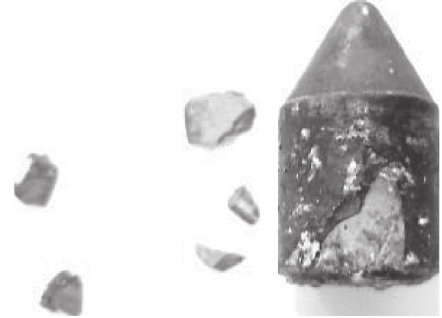
Figure 14: Failed cusp-conical indenter.